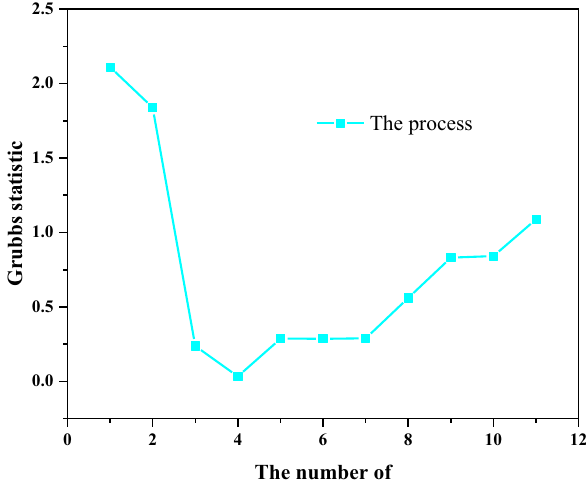
Figure 2: Processing diagram of group A1 data by the Grabbs method.